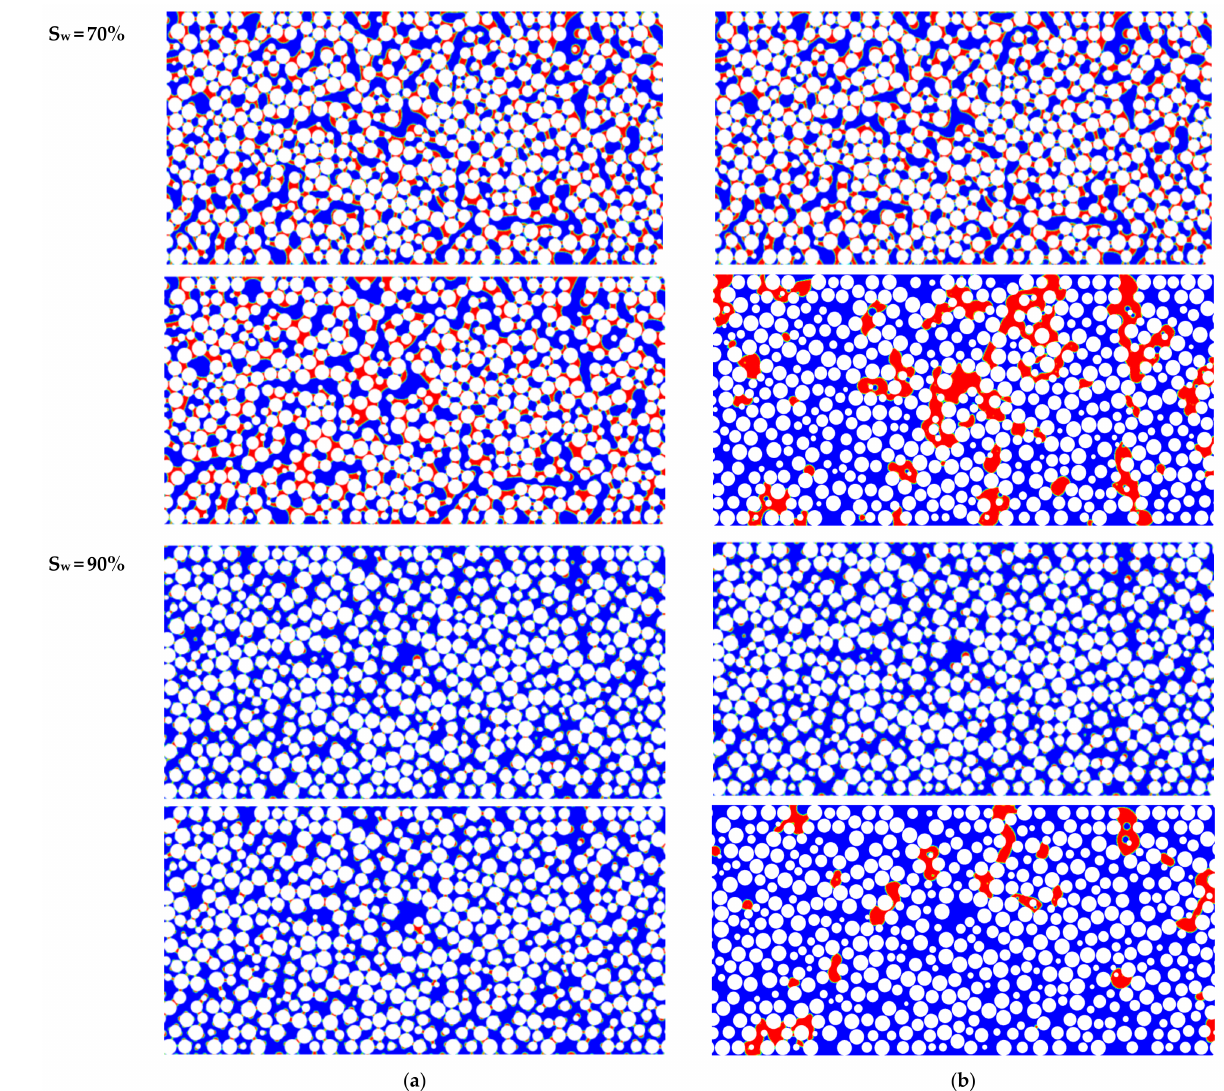
Figure 6. Distribution of oil (red) and displacing fluid (blue) at different water saturation of the porous medium. Displacement by water ( a ); nanosuspension ( b